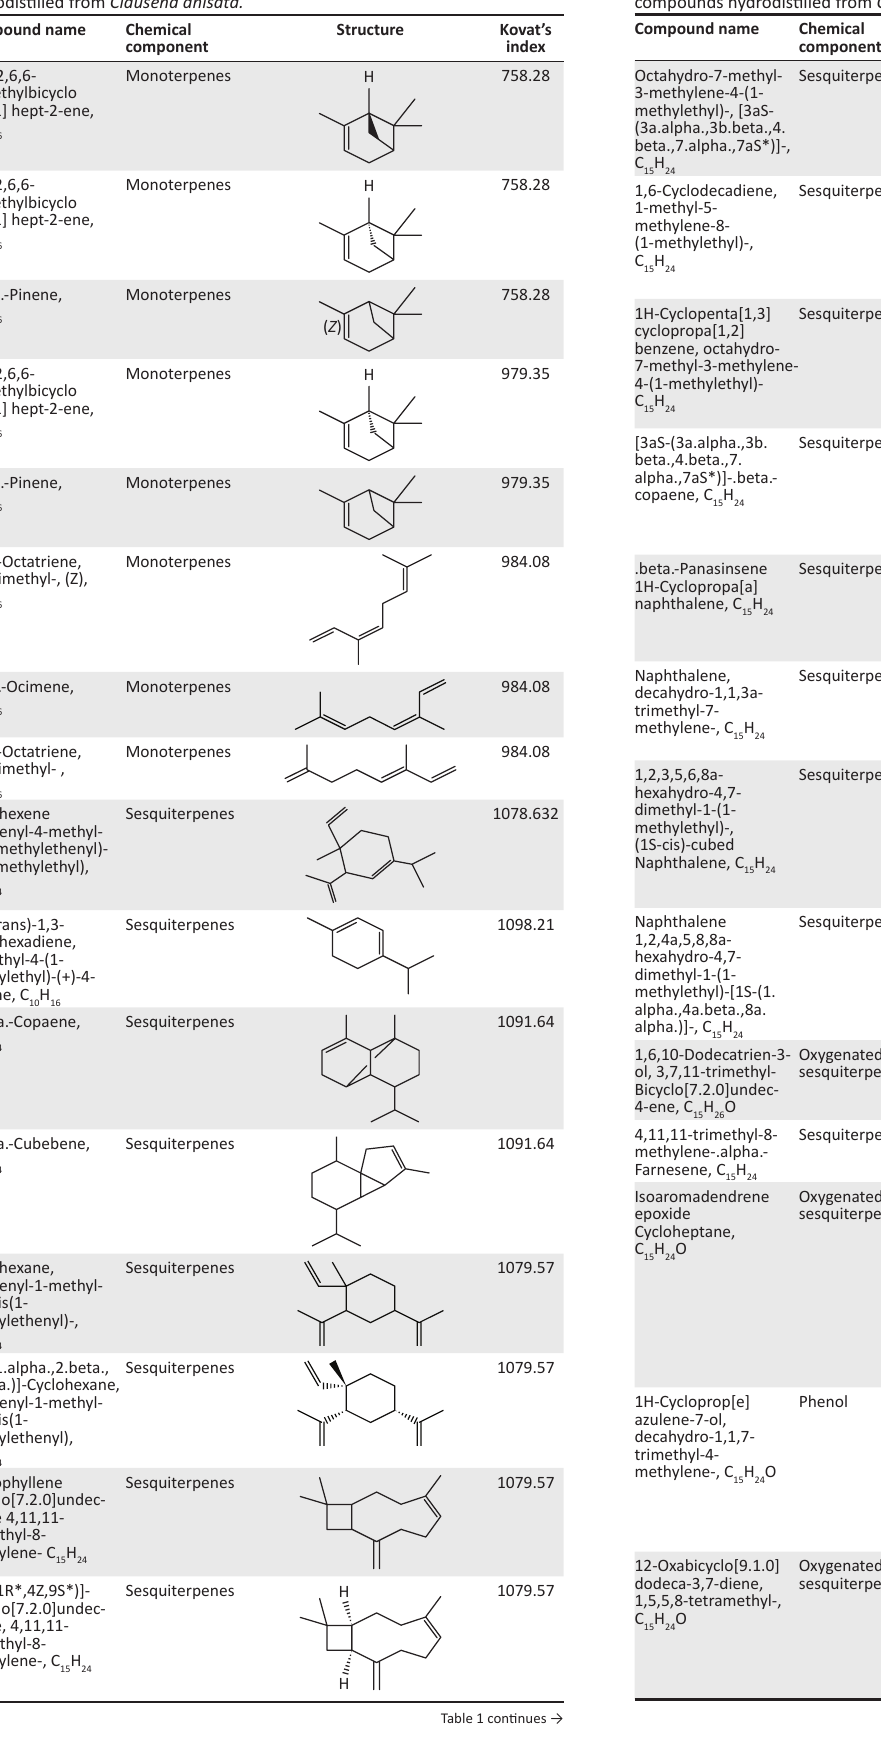
TABLE 1 (Continues...): Kovat’s index and structural formula of chemical compounds hydrodistilled from Clausena